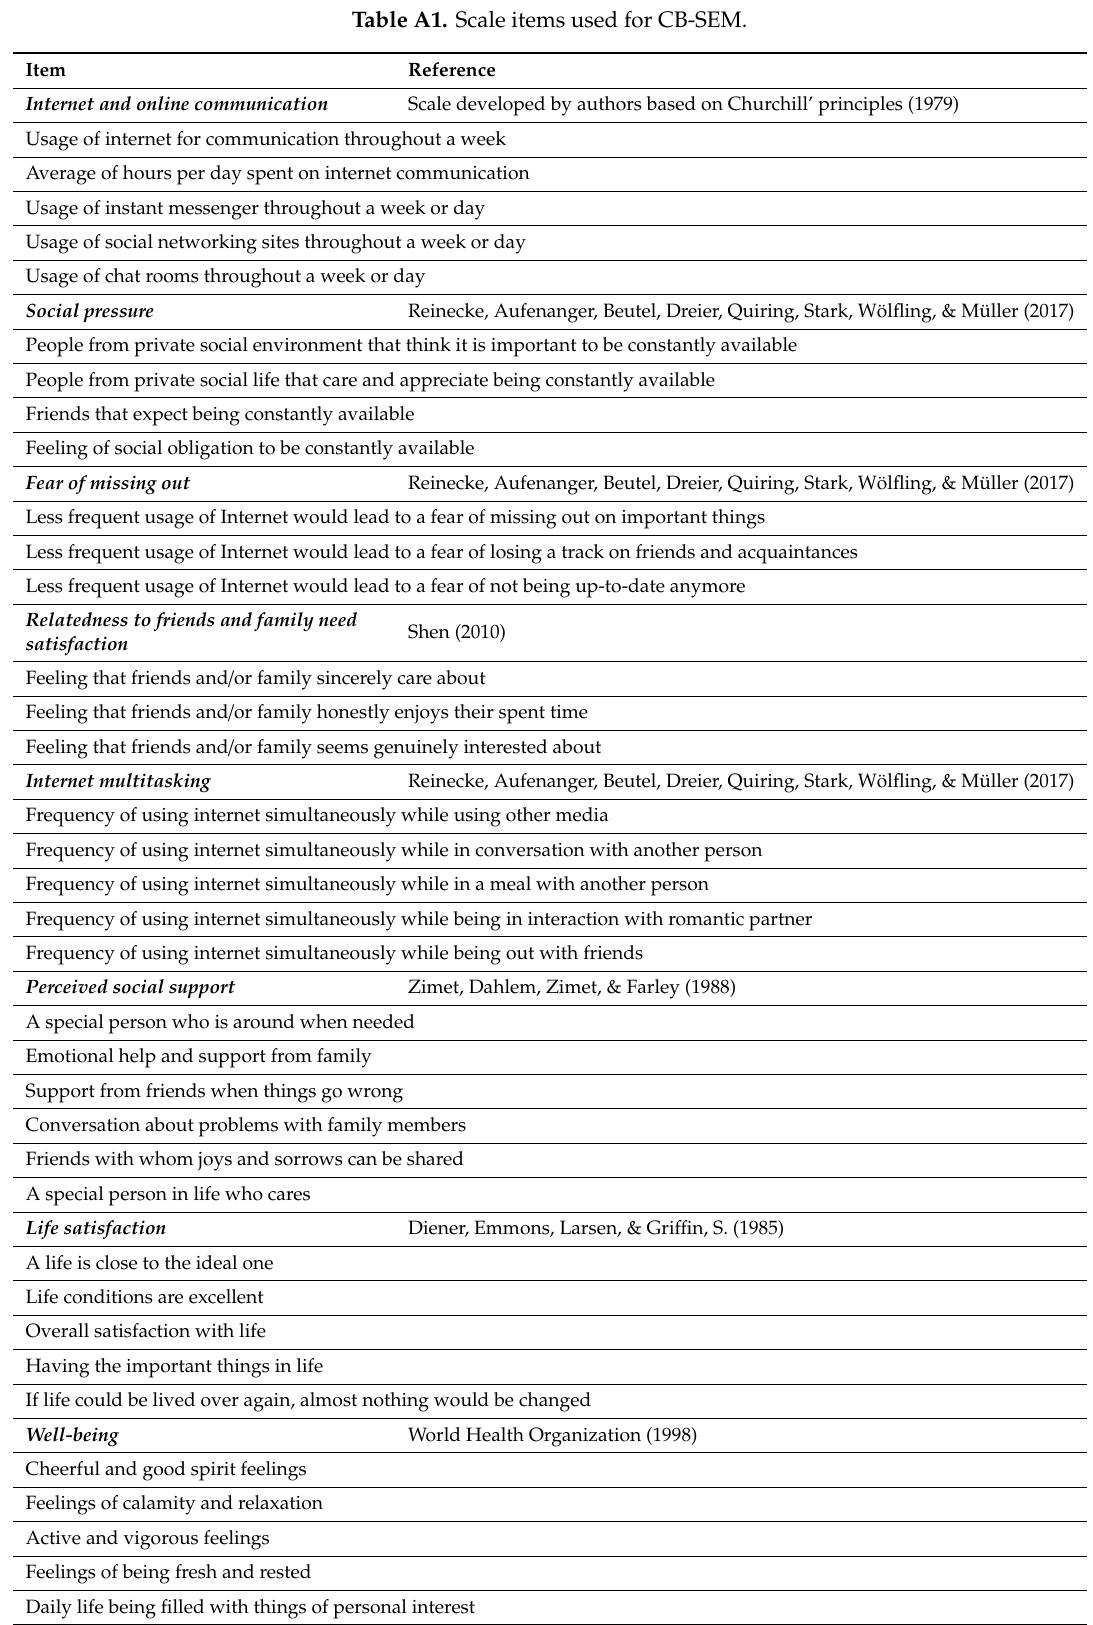
Table A1. Scale items used for